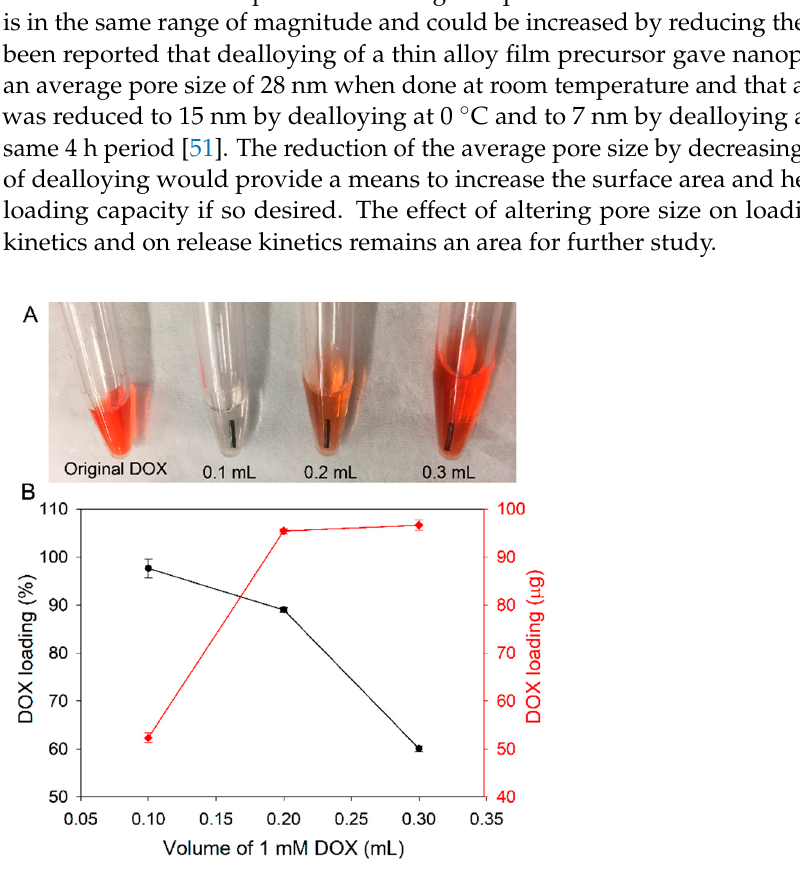
Figure 7. Typical atomic force microscopy (AFM) topographic images of np-Au before ( A ) and after DOX loading ( B ) and their corresponding 3D view and height distribution profiles on the right.